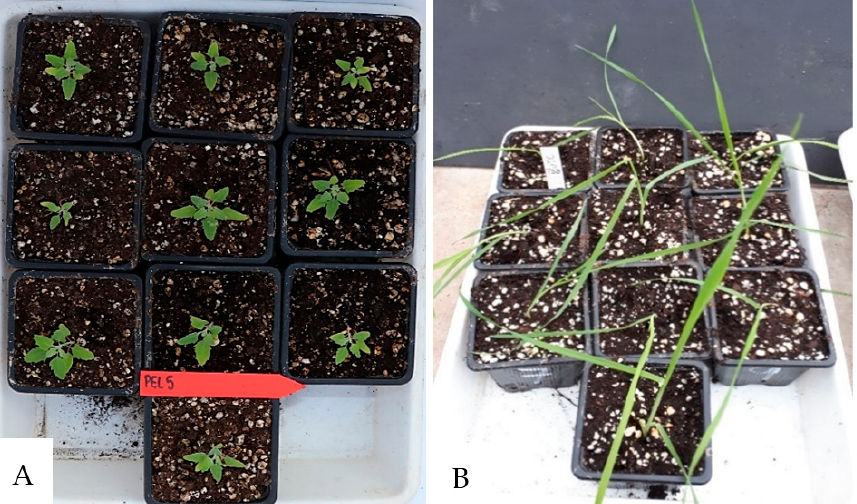
Figure 1. Weeds ready for being treated in the post-emergence herbicidal assays under greenhouse conditions, ( A ) Chenopodium album , ( B ) Avena fatua .